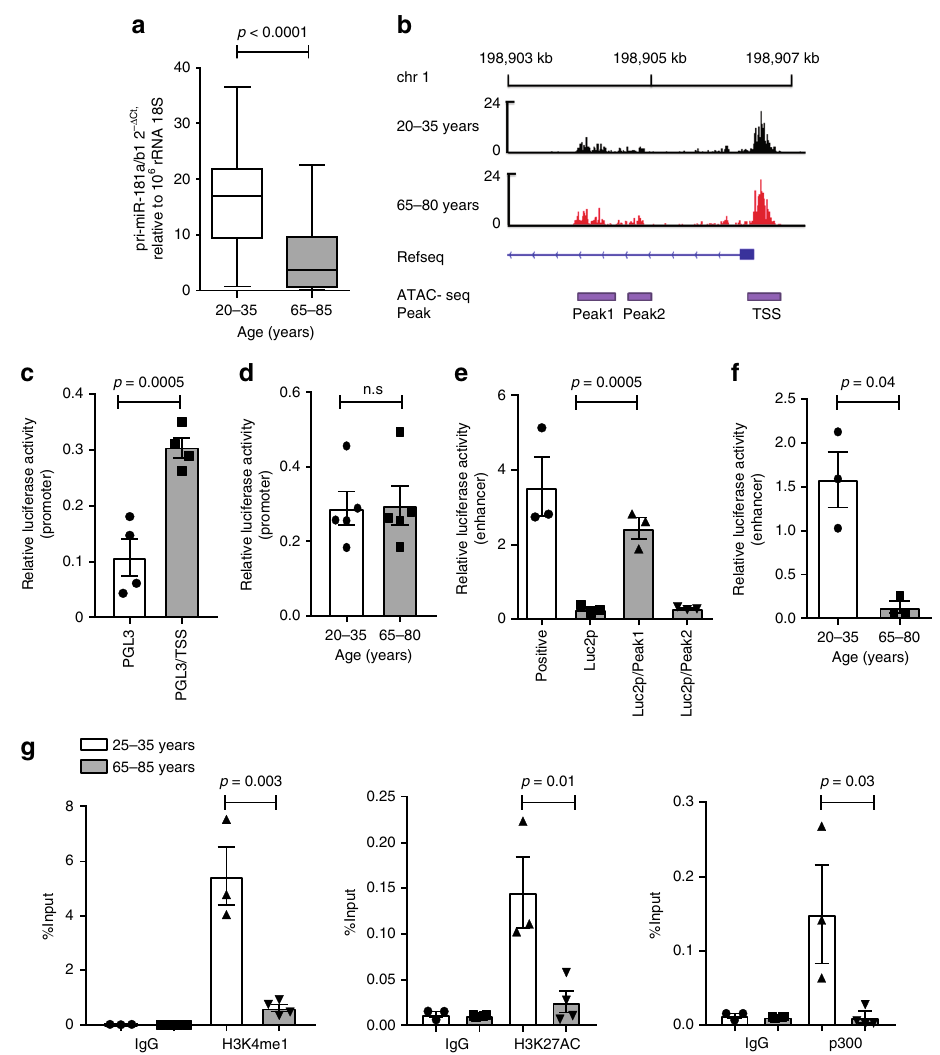
Fig. 1 Age-associated loss of miR-181a in naïve CD4 T cells with age is caused by reduced enhancer activity. a Expression of pri-miR-181a/b1 in naïve CD4 T cells was compared in 20 – 35 ( n = 20) and 65 – 85-year-old individuals ( n = 23). Results are shown as box plots of 2 − Δ CT (pri-miR-181a/b1 transcripts normalized to 10 6 18s rRNA) with medians, 25th and 75th percentile as boxes and 10th and 90th as whiskers. b Regions of chromatin accessibility were determined by ATAC-seq of naïve CD4 T cells. Tracks shown are merged from six young and four old adults and show open regions at 198,904,065 – 198,904,558 (Peak 1), 198,904,881 – 198,905,130 (Peak 2) and adjacent to the TSS of pri-miR-181a/b1 on chromosome 1 irrespective of age. c Dual luciferase reporter assays using pGL3-basic plasmids con fi rms promoter activity of the sequence adjacent to the TSS of miR-181a/b1 shown as mean ± SEM ( n = 4). d Results from reporter gene assays using the pri-miR-181a/b1 promoter constructs transfected into naïve CD4 T cells are shown as mean ± SEM from young ( n = 5) and old adults ( n = 5). e Sequences corresponding to Peak 1 and Peak 2 were cloned into a pGL4.27 [luc2P/ minP/Hygro] plasmid. Dual luciferase reporter assays showed enhancer activity for Peak 1 but not Peak 2 sequences; mean ± SEM are shown ( n = 3). f Dual luciferase reporter assays showed increased enhancer activity for young naïve CD4 T cells. Results are shown as mean ± SEM from young ( n = 3) and old ( n = 3) adults. g ChIP-PCR for Peak 1 sequences were performed with antibodies to H3K4me1 (left), H3K27AC (middle), and p300 (right). Results are shown as mean ± SEM of naïve CD4 T cells from young ( n = 3) and old ( n = 4) adults. All comparisons were done by two-tailed unpaired